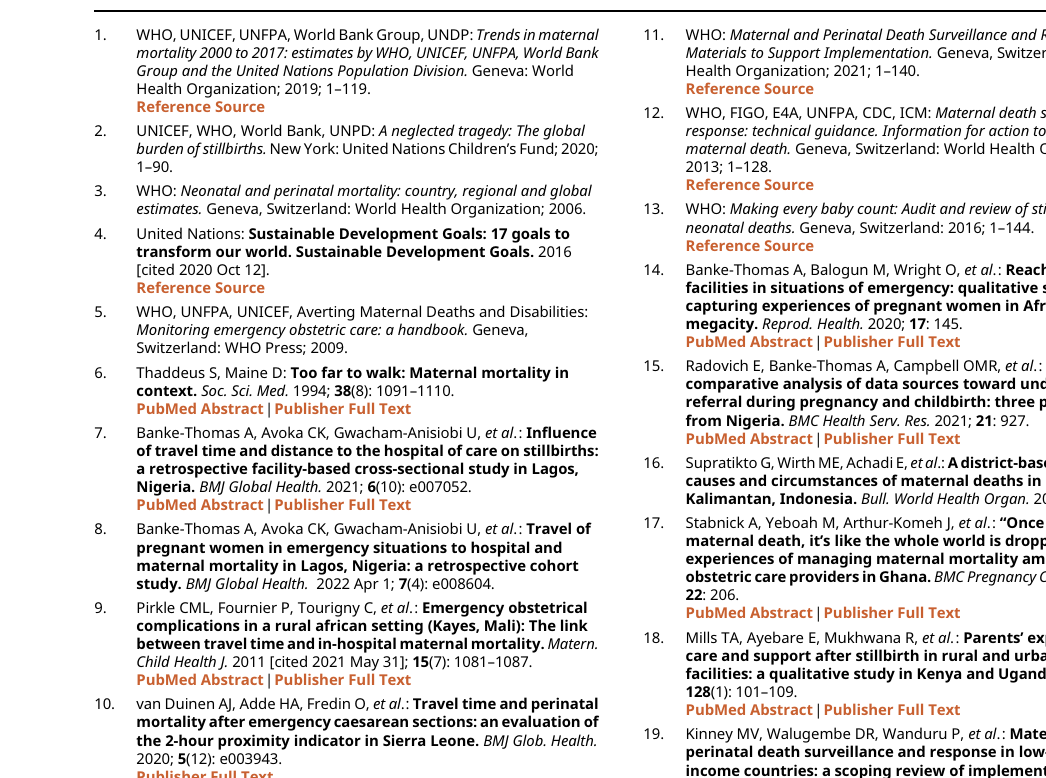
Figshare: Intra-facility_maternal_deaths_Lagos_2018-2019.csv. https://doi.org/10.6084/m9.figshare.20098148.v1.